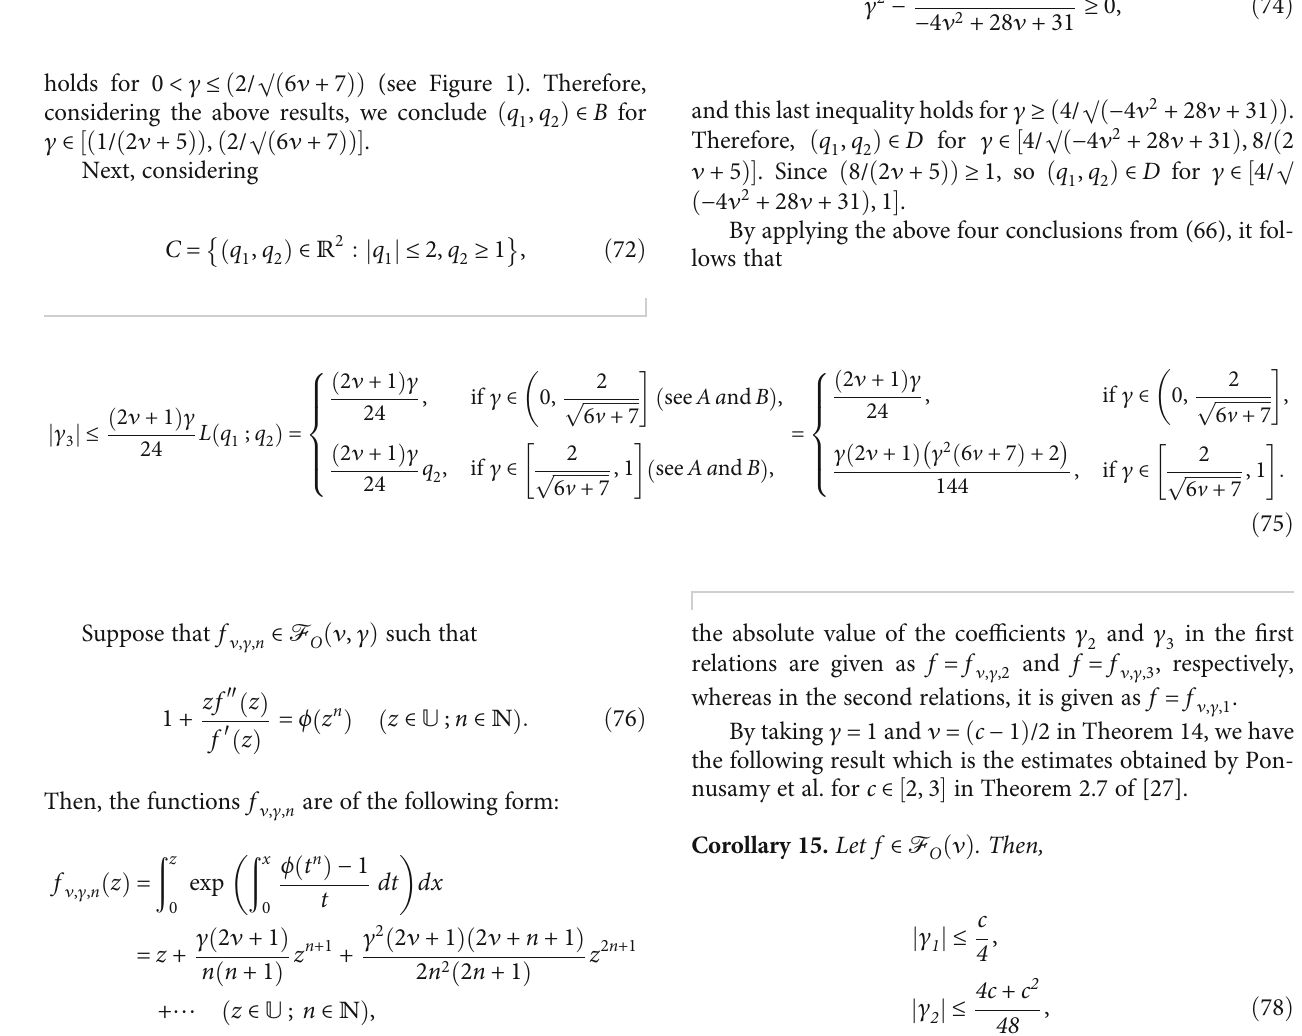
Figure 1: The plot of g ð ν , γ Þ for γ = 0 ⋯ 2/ √ ð 6 ν + 7 Þ , ν = 1/2 ⋯ 1 :